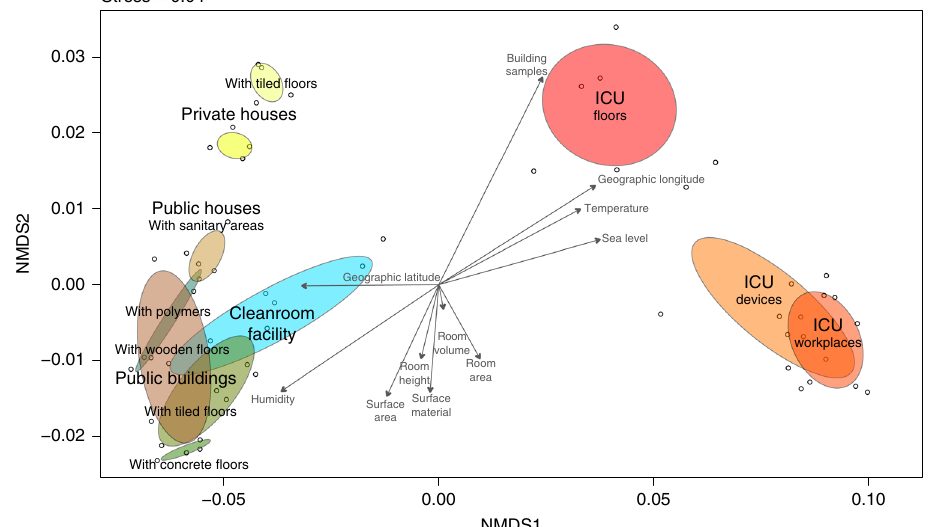
Fig. 3 Environmental variables associated with the microbiome of sampled built environments. NMDS of 16S rRNA gene amplicons based on Bray – Curtis distances with superimposed vectors representing Spearman correlations of measured environmental variables (bioenv) based on Eucledian distances. Color code for column environment: blue (cleanroom facility); red (intensive care unit); dark green (public buildings); light green (public houses); yellow